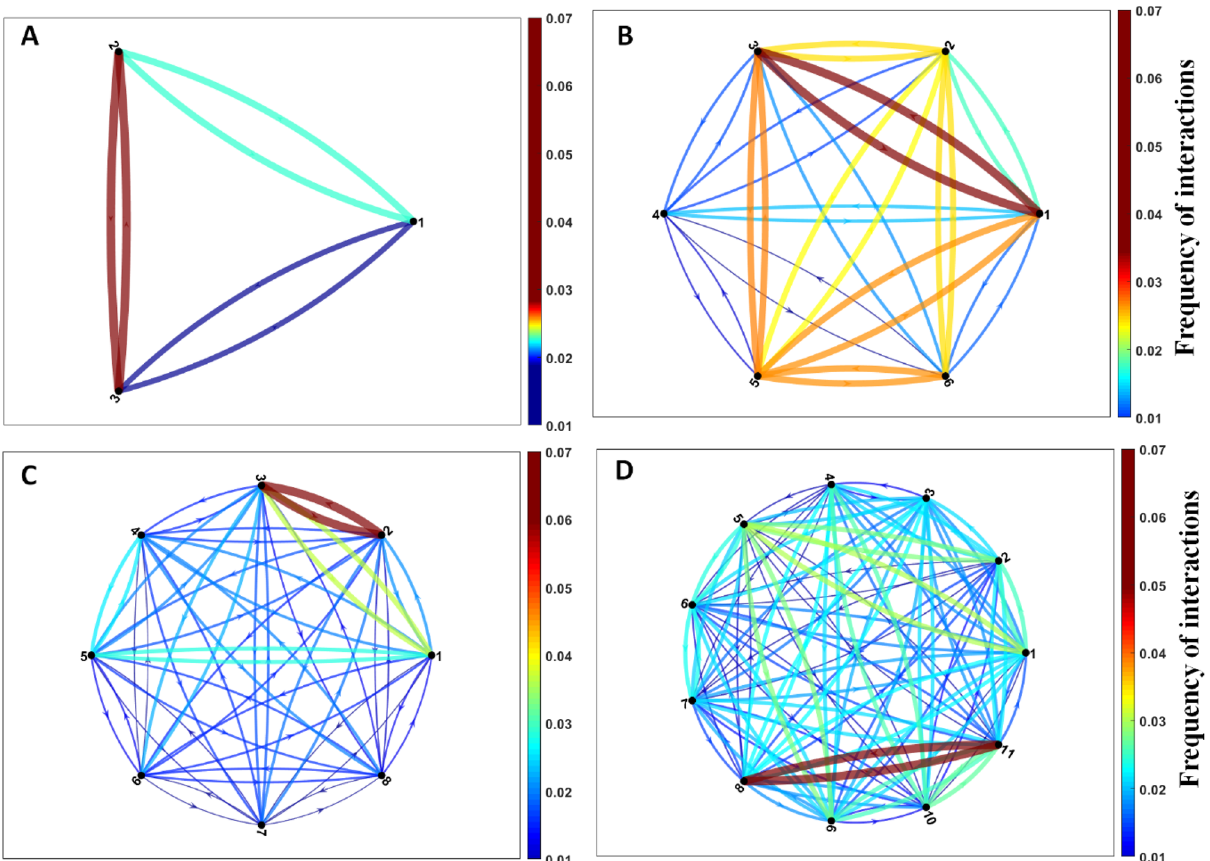
Figure 7. Network of zebrafish shoal interactions. Mutual information was measured from the difference in the angle of the fish’s head during movement in the video. Two arrows connect two fish during locomotor activity, being the response of the influence of one fish to another target fish. The line thickness represents the frequency of interactions. Frequency of interactions of the group with three fish ( A ), six fish ( B ), eight fish ( C ) and eleven fish ( D